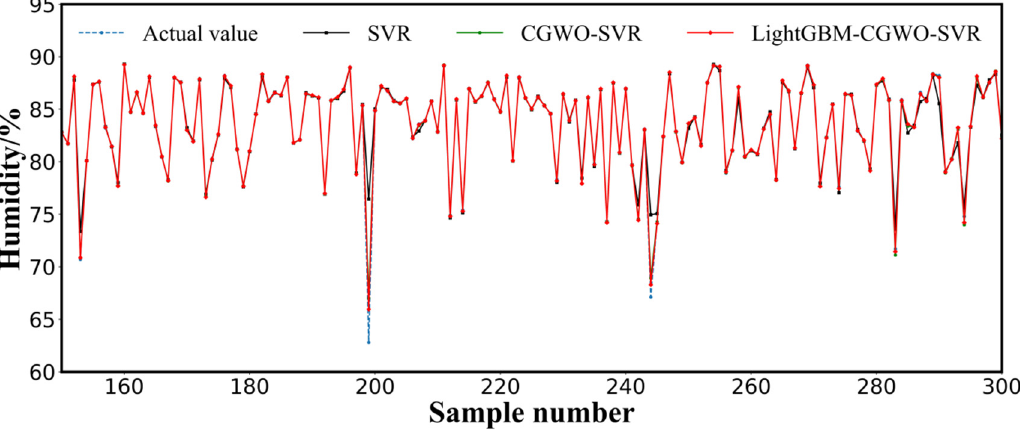
Figure 7. Actual versus computed humidity of SVR, CGW–SVR, and LightGBM–CGWO–SVR (part of validation data). of validation